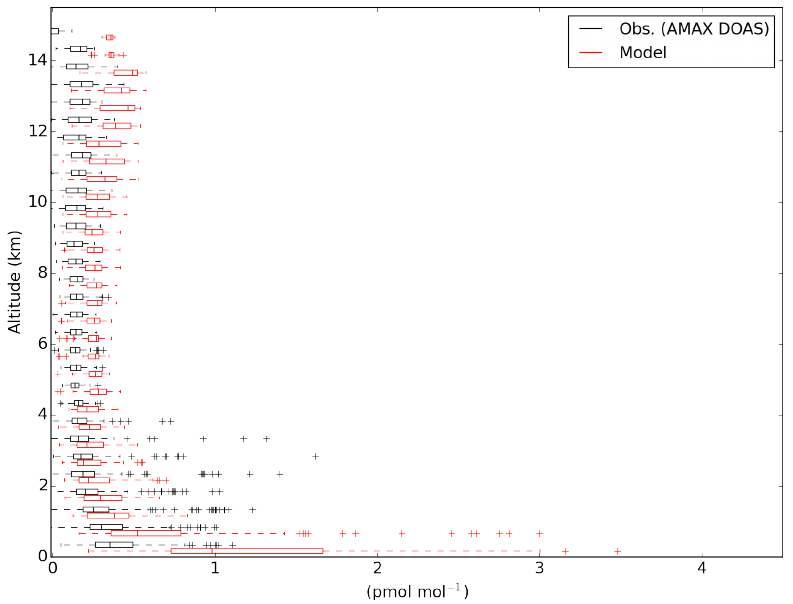
Figure 6. Vertical comparison of the simulation with both iodine and bromine chemistry (“Br + I”) and measured iodine oxide (IO) during TORERO aircraft campaign (Volkamer et al., 2015; Wang et al., 2015). Model and observations are in red and black respectively. Values are considered in 0.5km bins, with observations and modelled values at the same location and time (as described in Sect. 2) shown side-by-side around the mid-point of each bin. Measurements were taken aboard the NSF/NCAR GV research aircraft by the University of Colorado airborne Multi-Axis DOAS instrument (CU AMAX-DOAS) in the eastern Pacific in January and February 2012 (Volkamer et al., 2015; Wang et al., 2015) . The boxplot extents give the inter-quartile range, with the median shown within the box. The whiskers give the most extreme point within 1.5 times the inter-quartile range.